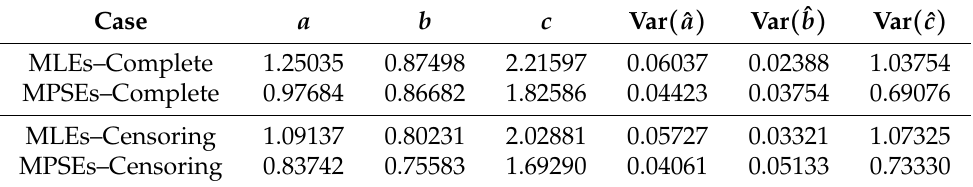
Table 3. Estimates and their asymptotic properties, based on Table